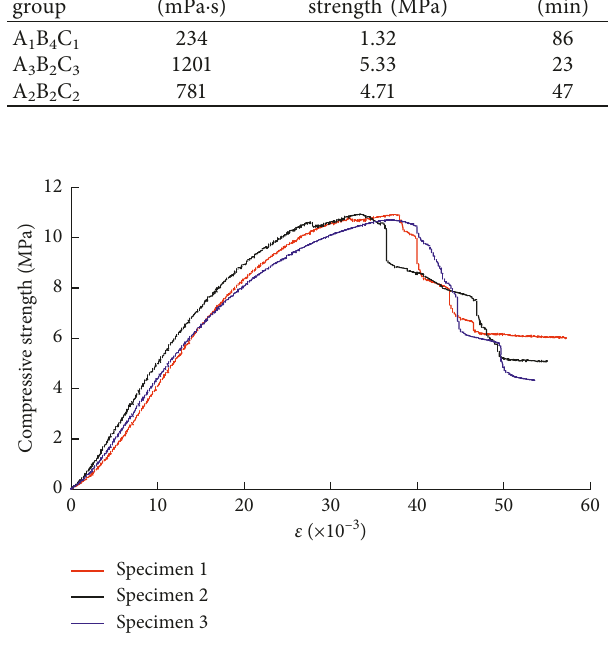
Figure 5: Stress-strain relation curves of the specimens.